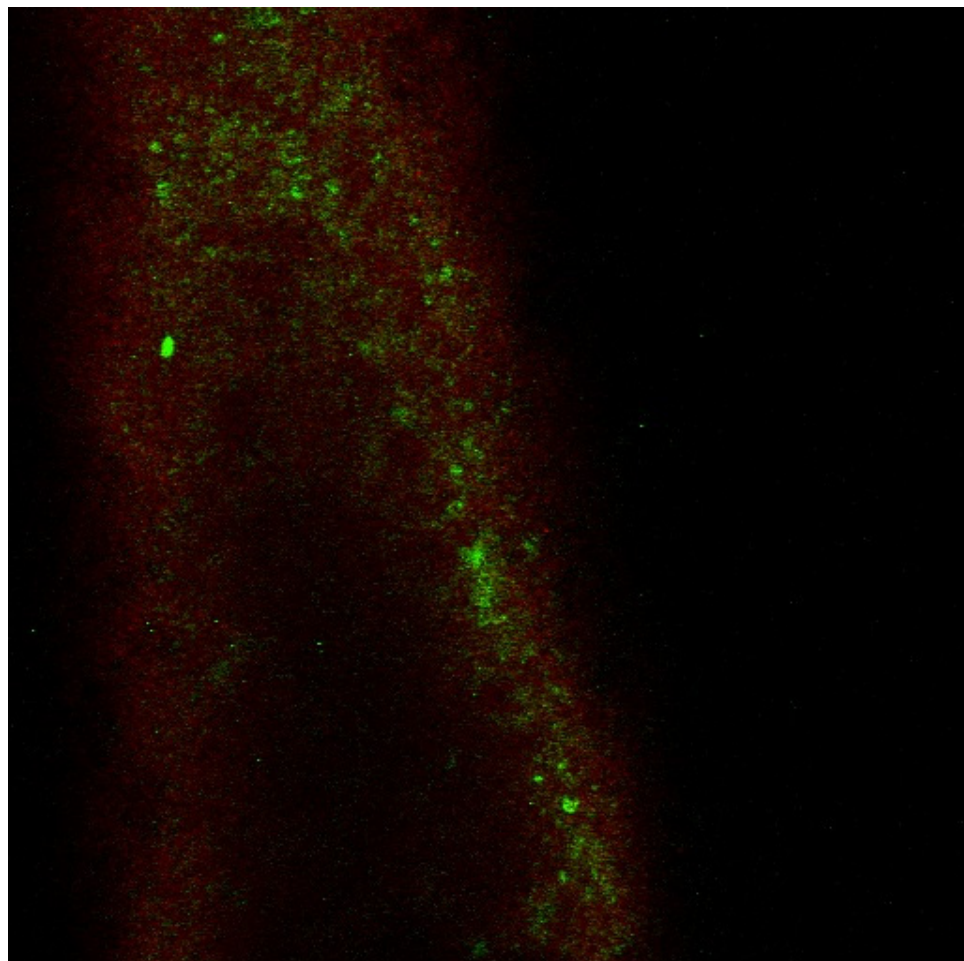
Figure 1. Confocal laser scanning microscopy image of bacteria and biofilm generated over a gutta- percha segment.